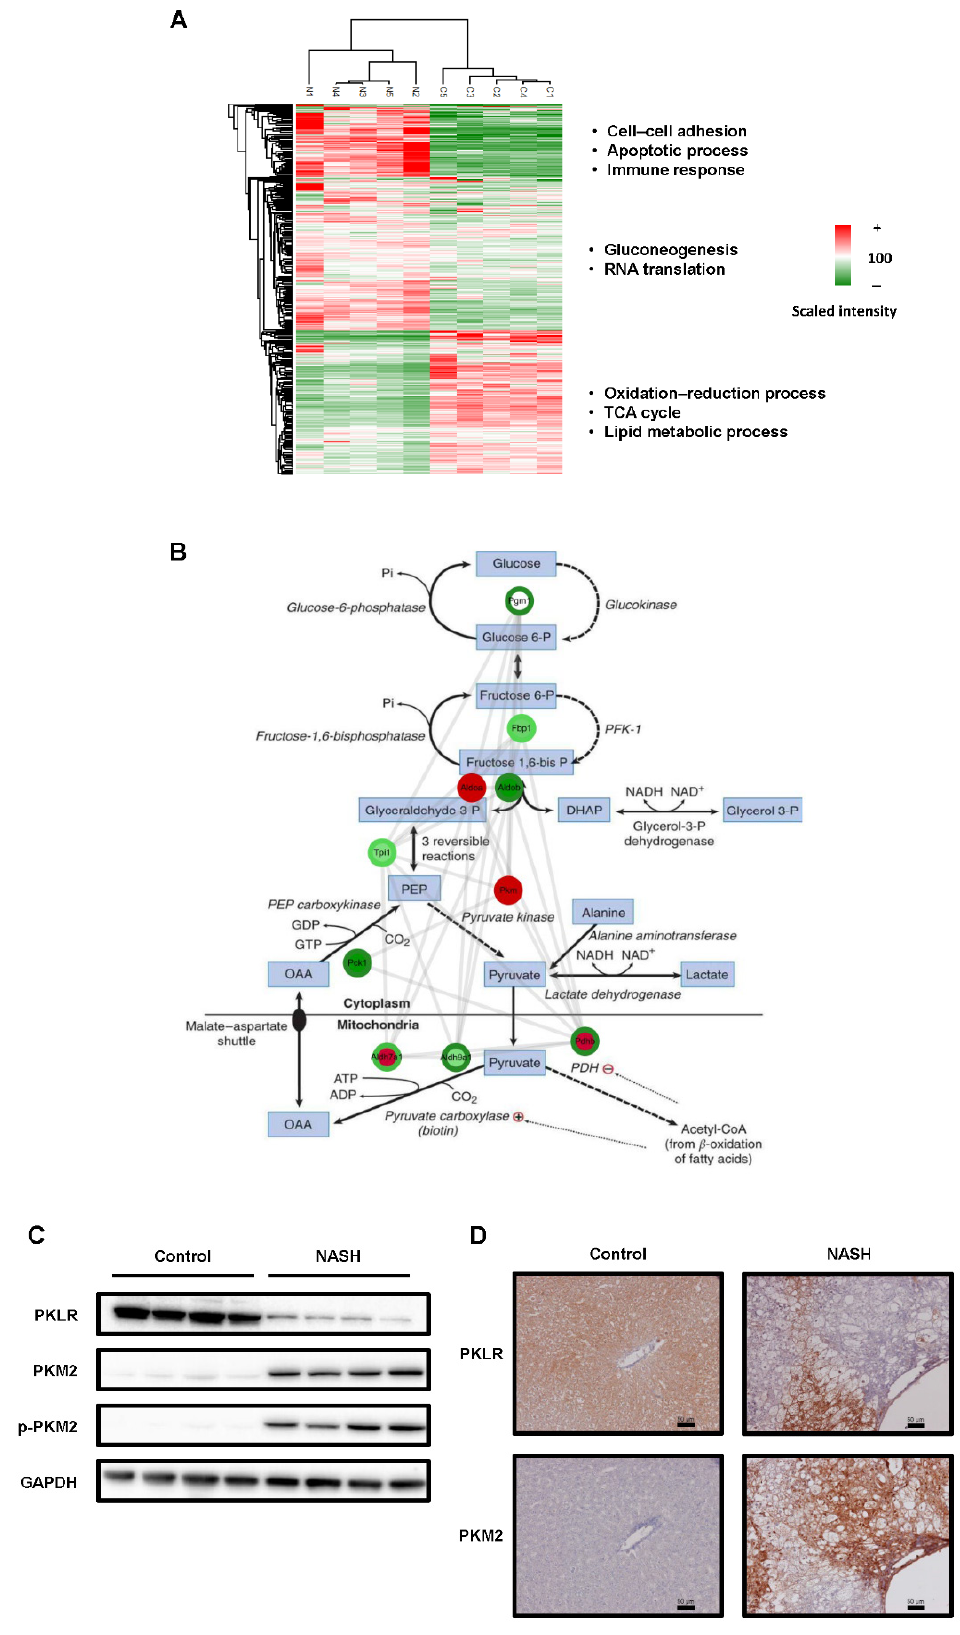
Figure 2. Changes in glycolysis and the expression of rate-limiting enzyme PKM2 in rat models of non-alcoholic steatohepatitis (NASH). ( A ) Heat map of the phosphoproteome. Quantitative changes in protein phosphorylation of each pathway. A significant difference was observed for each